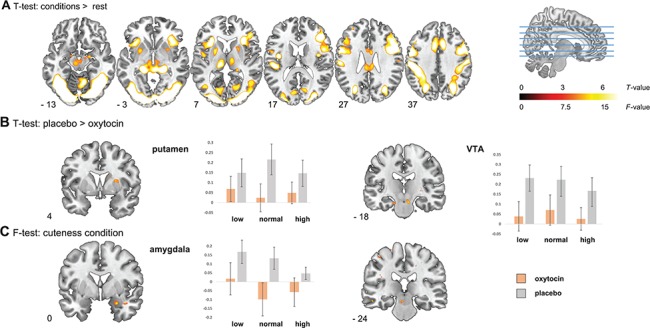

A, Axial slices with corresponding Y-coordinates (MNI) from the T-map of neural activation of all infant faces vs rest overlaid onto a standard anatomical template. B, Coronal slices with corresponding X-coordinates (MNI) from the T-map of neural deactivation toward all infant faces for oxytocin vs placebo, depicting significant deactivation in the VTA (right) and putamen (left). C, Coronal slices with corresponding X-coordinates (MNI) from the F-map of the effect of cuteness condition of the stimuli in both administration conditions. Significant modulation by cuteness was observed in the VTA (right) and amygdala (left). For the VTA, putamen and amygdala bar graphs of the parameter estimates extracted from anatomical bilateral ROIs in all conditions vs rest are displayed. Accompanying statistics are described in the text. All statistical maps are thresholded at P = 0.001 uncorrected, for illustration purposes only. Non-thresholded statistical maps of the main fMRI analyses can be found at the NeuroVault data repository (http://neurovault.org/collections/3699/).